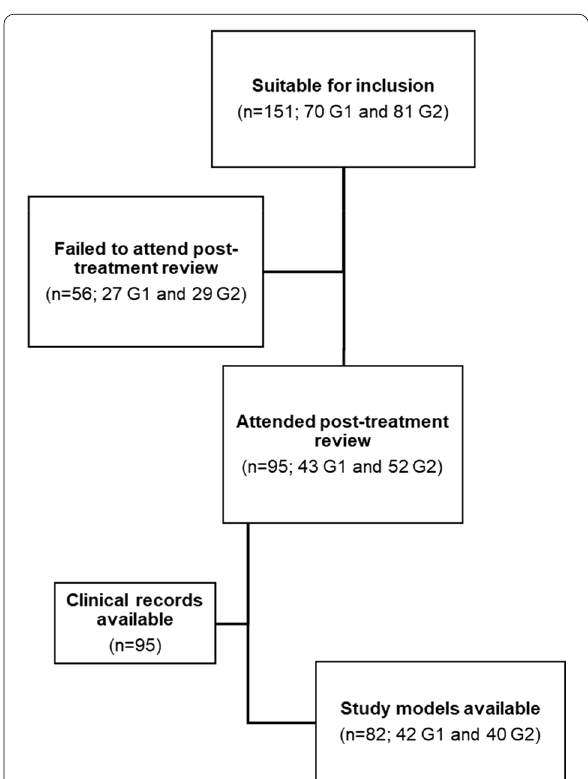
Fig. 2 Participant flow and availability of records (Group 1: residual overjet group; Group 2: normal overjet